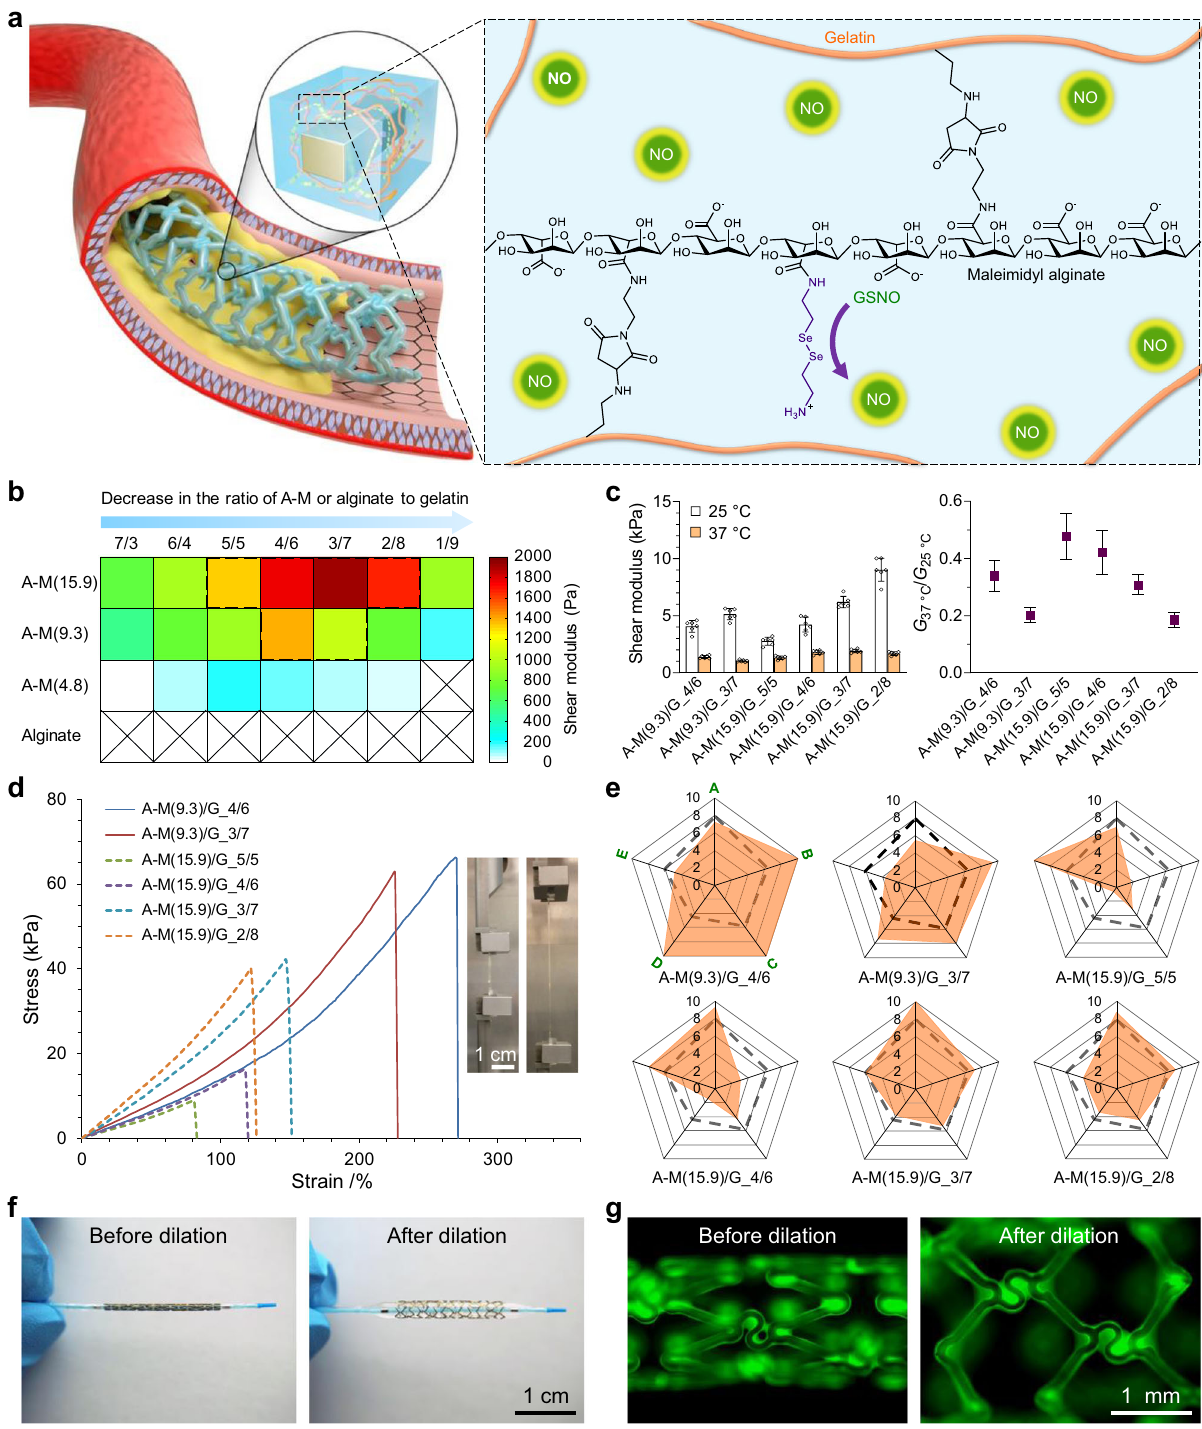
Fig. 1 Development of a tough nitric oxide-eluting (NOE) hydrogel coating for vascular stent. a Schematic for the design of our NOE hydrogel. b Shear moduli (at 37 °C) of the hybrid hydrogels formulated with maleimidyl alginate (A – M) of varying degrees of modi fi cation (DM) and gelatin (G) at different mass ratios. c Comparison in shear modulus among the selected hydrogels at 25 °C and 37 °C (mean ± SD, n = 6 independent samples). d Tensile testing of them at ambient temperature. The insets exhibit the photographs of A – M(9.3)/G_4/6 hydrogel prior to and during extension. e Radar charts showing their scores in shear modulus (at 37 °C) (A), fracture strength (B), fracture strain (C), toughness (D), and capacity for further modi fi cation (E). Dashed frameworks represent the average values. f Photographs of a vascular stent coated with A – M(9.3)/G_4/6 hydrogel before and after balloon dilation in PBS at 37 °C. g Fluorescence images of it before and after balloon dilation. The hydrogel coating was labeled with fl uorescein